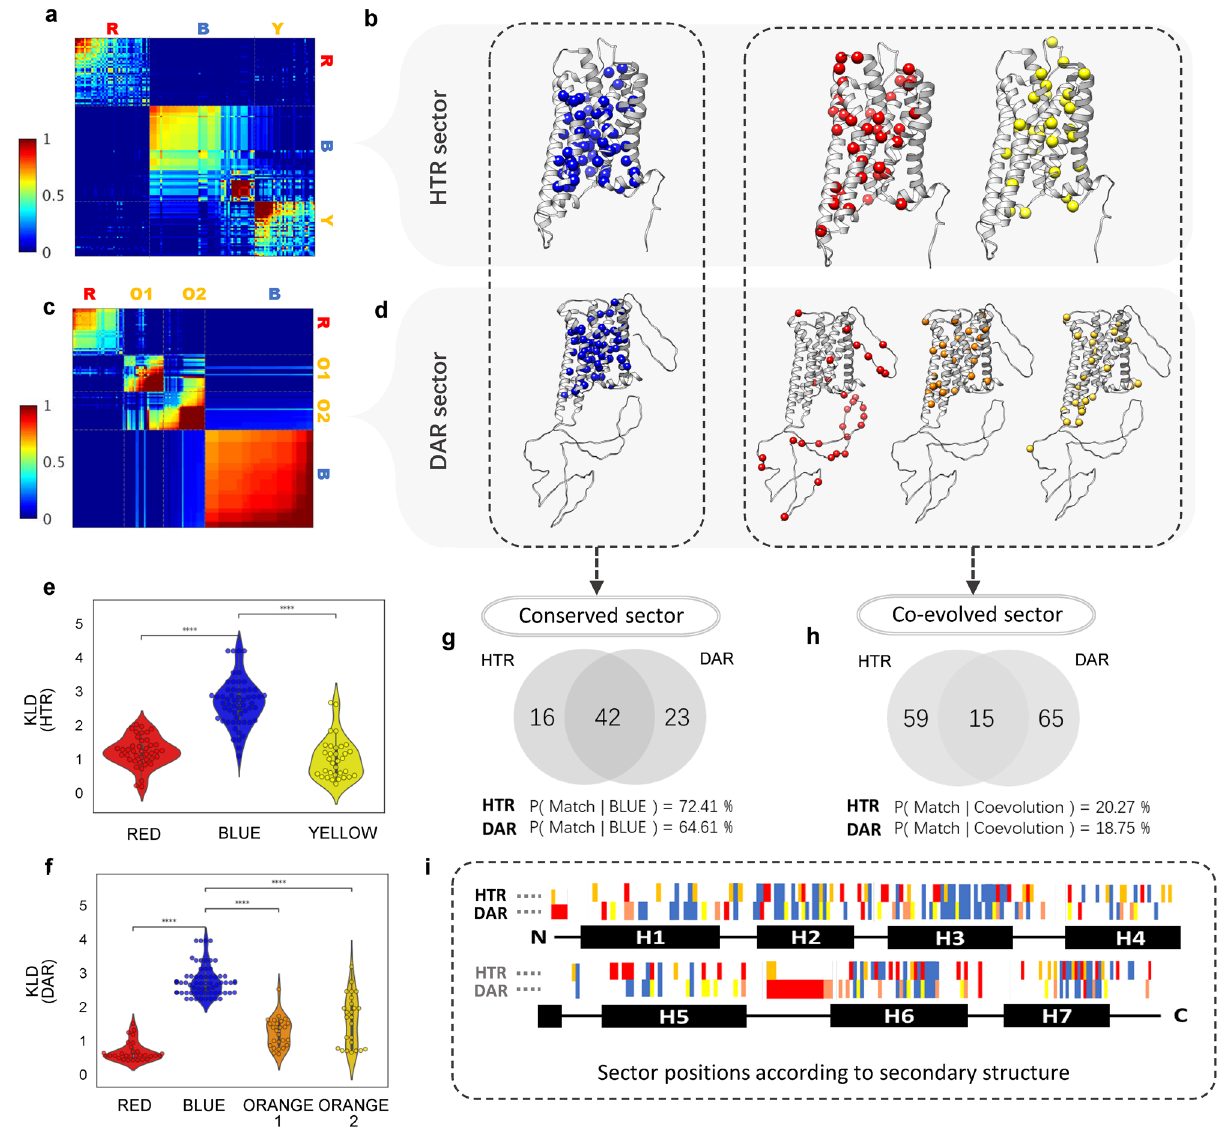
Figure 3. GPCRs have coevolved sectors and a common conserved sector. ( a ) Sector matrix of 5-HT receptor. ( b ) Structure representations of sectors of 5-HT receptor. ( c ) Sector matrix of DA receptor. ( d ) Structure representations of sectors of DA receptor. DAR-Orange1 is colored in orange, and DAR-Orange2 is colored in yellow. ( e ) Kullback–Leibler divergence of sectors of 5-HT receptor. Mann–Whitney test is performed between sectors. (****p ≤ 1.00e−04) ( f ) Kullback–Leibler divergence of sectors of DA receptor. Mann–Whitney test is performed between sectors. (****p ≤ 1.00e−04) ( g ) Venn-diagram of matched residue between HTR-Blue sector and DAR-Blue sector. ( h ) Venn-diagram of matched residue between coevolved sectors of HTR and DAR. ( i ) Sector positions of HTR and DAR according to secondary structure. At DAR row of ( i ), Orange color represents DAR-Orange1 and yellow represents